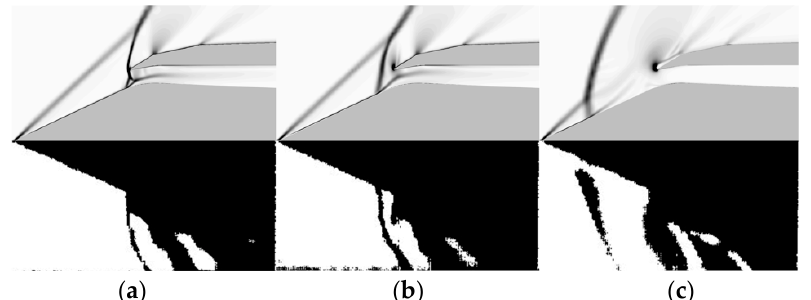
Figure 4. Numerical schlieren image (upper half) and experimental schlieren image [2] (lower half) at different moments within one cycle: ( a ) Moment 1; ( b ) moment 2; ( c ) moment 3.